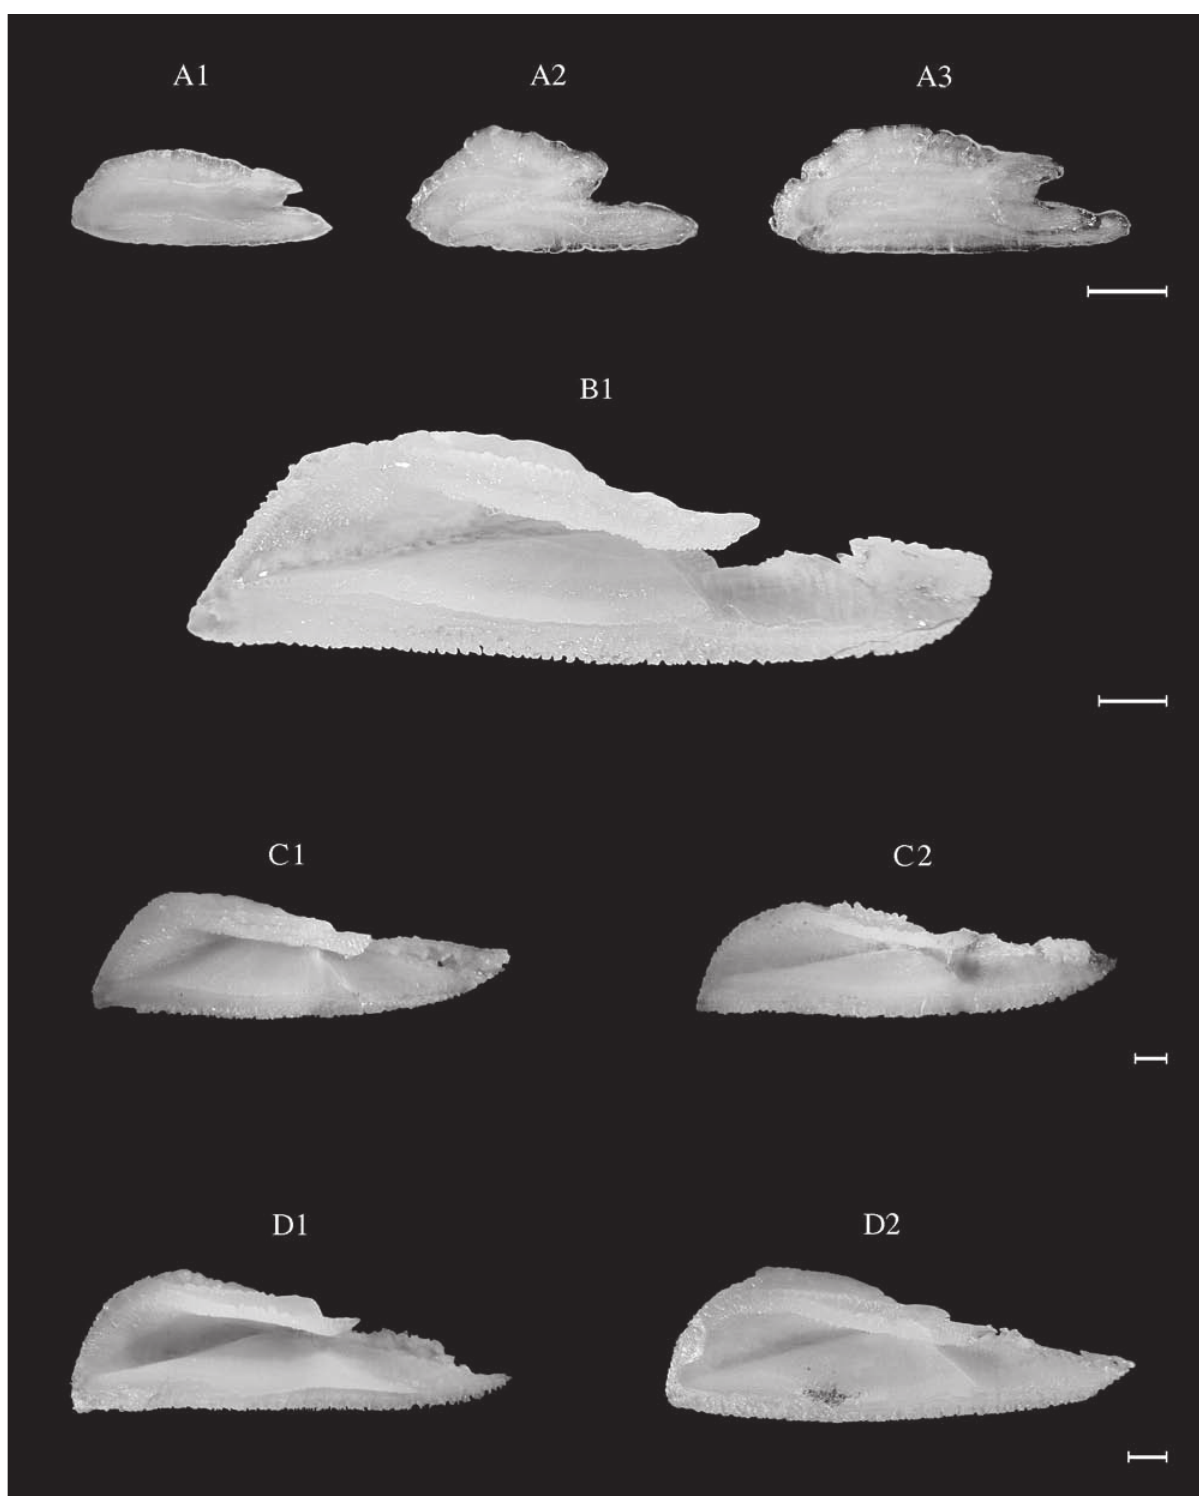
Fig. 85. – Scomber scrombrus . FL: A1, 18.1 cm (WM); A2, 32.2 cm (NEA); A3, 36.5 cm (NEA). Thunnus alalunga (CEA). FL: B1, 123.7 cm. Thunnus obesus (CEA). FL: C1, 92.0 cm; C2, 93.0 cm. Thunnus thynnus (WM). FL: D1, no available data. Scale bar = 1